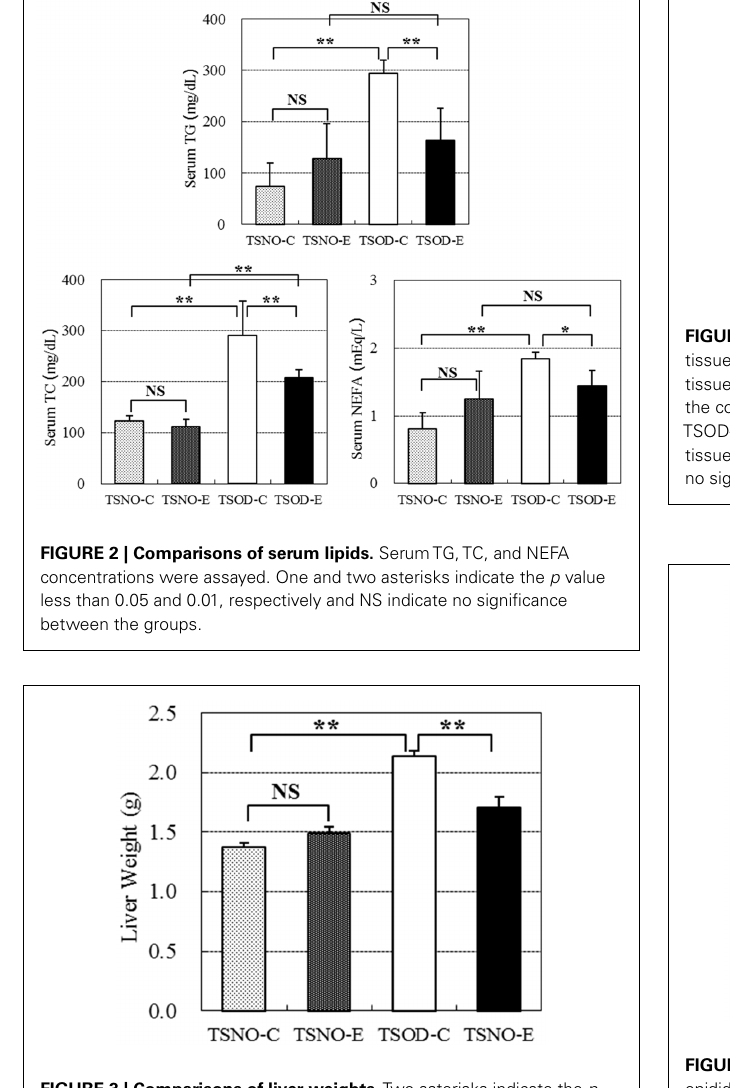
FIGURE 3 | Comparisons of liver weights. Two asterisks indicate the p value less than 0.01 and NS indicate no significance between the groups.